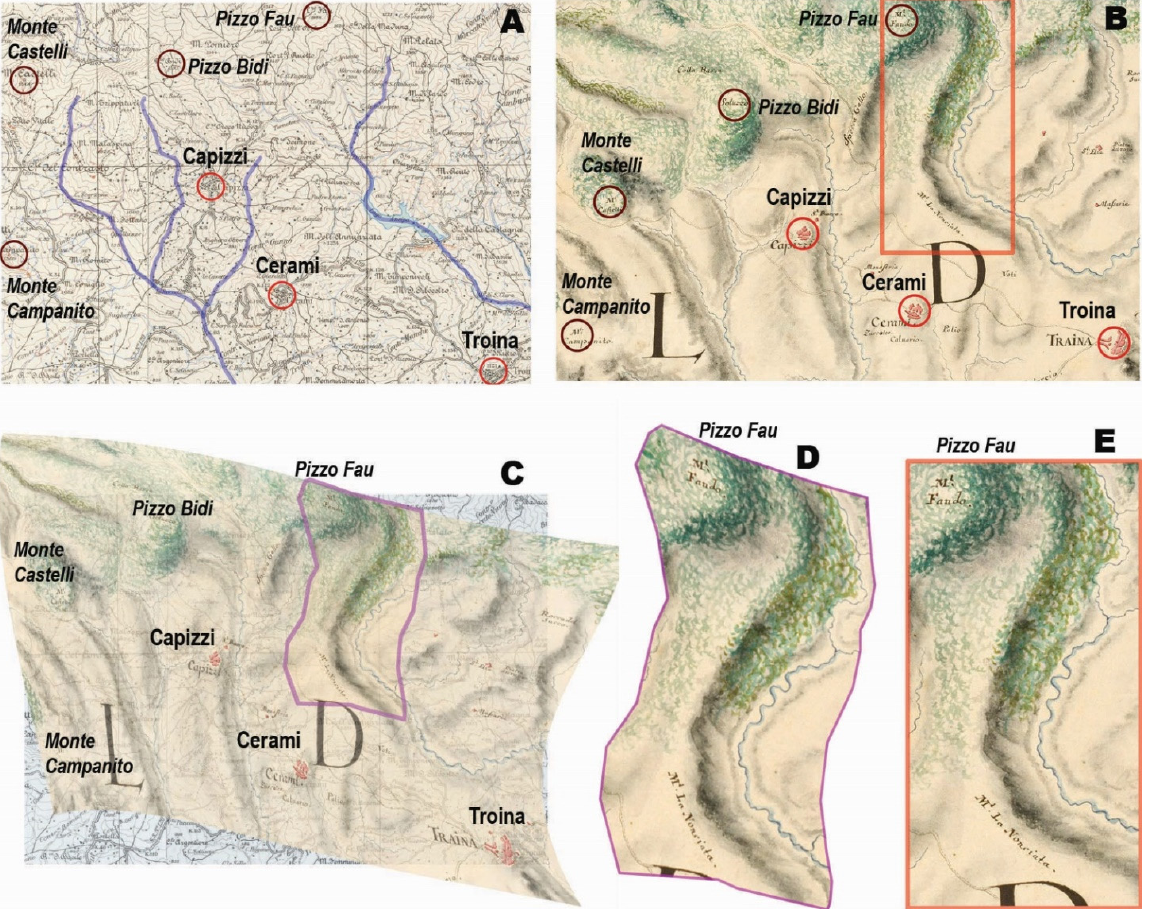
Figure 3. Comparative analysis of main relief forms on map of Sicily, comparing the location of mountain peaks, the course of mountain chains and the rivers (with the location of four peaks, three towns, and main rivers) on the map of Sicily, ca.1:80,000, 1722 ( B ), and topographic map of Italy, sheet: Bronte, 1955, UTM, 1:100,000 ( A ): irregular distortion of old map frame ( C ): distortion of the center of the graphic expression of the valley/ridge south of Pizza Mountain ( D ): original painting style before rectification ( E ).